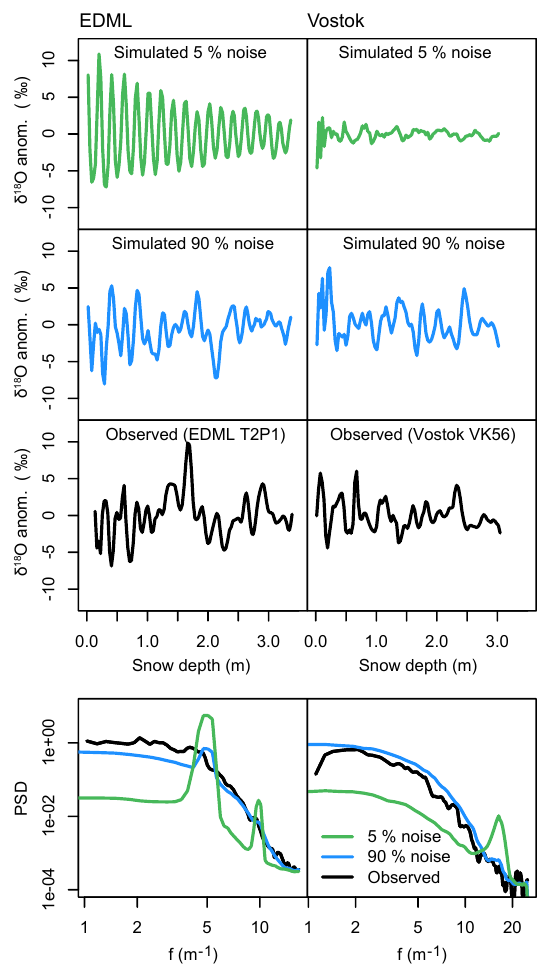
Figure 8. Visual comparison of measured and simulated profiles for EDML (left) and Vostok (right panel). Upper row: simulations for 5% noise, representing a pure climate signal. Middle row: simula- tions for 90% noise. Bottom row: power spectra of the simulated and observed isotope profiles. The observed spectra are the mean of all spectra from the profiles available for the site. The simulated spectra are the mean spectra over 100 realisations of the isotope